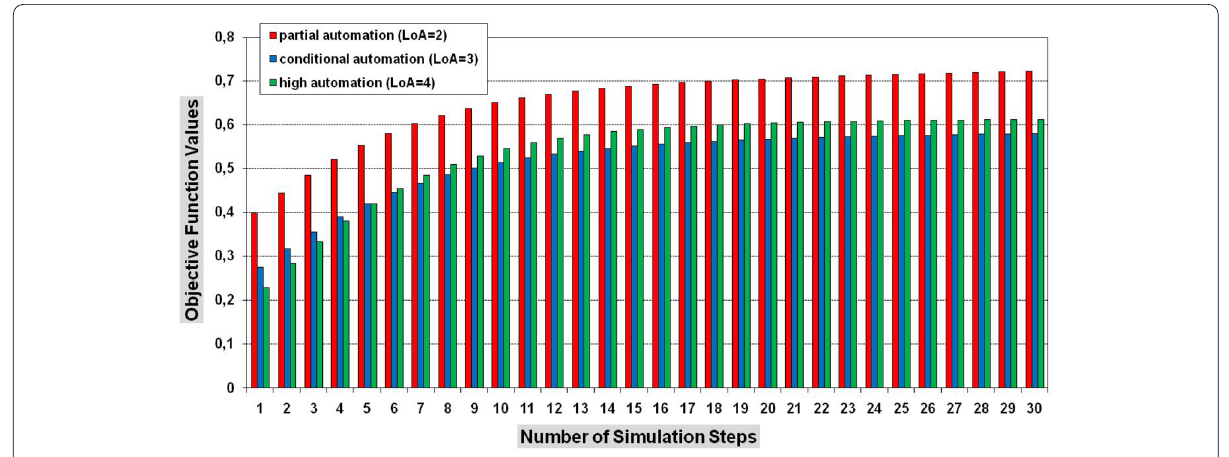
Figure 8 Objective Function values (OFtotal) for all the available in vehicle levels of autonomy ( LoA = 2,3 and 4) at point